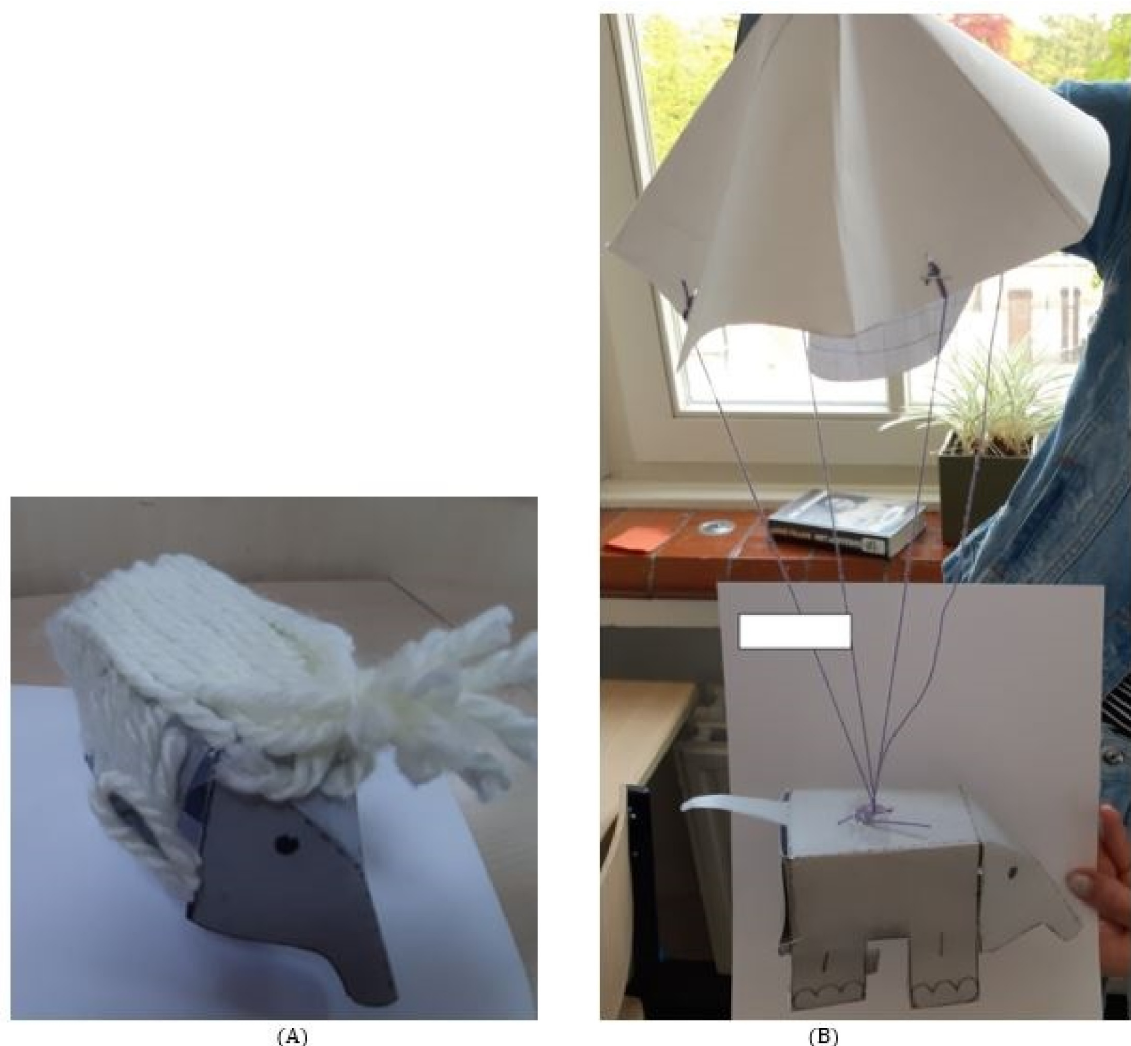
Fig 2. Two examples of final products for the toy elephant. Picture A presents the idea of ‘make the elephant soft’, and picture B presents the idea of ‘make the elephant in such a way that it can